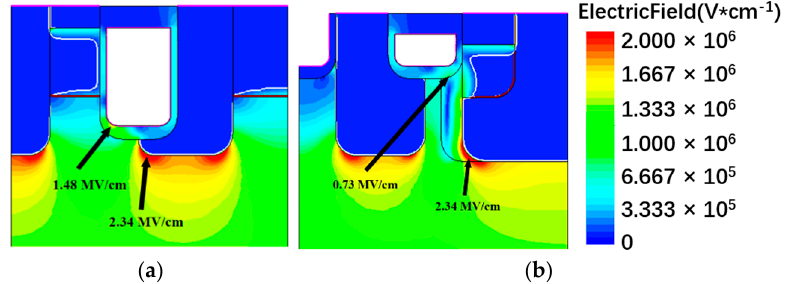
Figure 4. The electric field distribution of ( a ) C-MOS, ( b ) proposed structure.